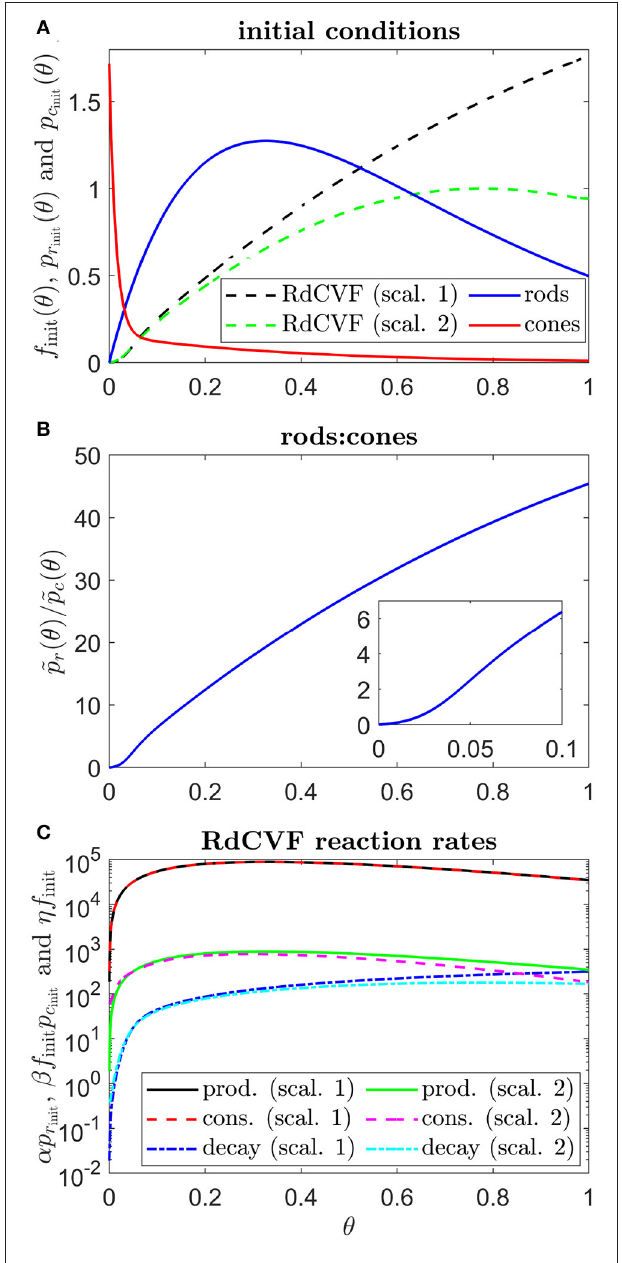
FIGURE 3 | Initial conditions, ratio of rods to cones and RdCVF reaction rates. (A) initial conditions used in all simulations, consisting of healthy rod and cone profiles and the corresponding RdCVF profiles under Scalings 1 and 2 (the legend applies to (A) only). (B) variation in the healthy rod:cone ratio, ˜ p r ( θ ) / ˜ p c ( θ ), with eccentricity. (C) RdCVF production, consumption and decay rates under Scalings 1 and 2 (Equation (1), the legend applies to (C) only). To obtain f init ( θ ) in (A,C) , Equations (1) and (4) were solved at steady-state using the finite difference method, with 4001 mesh points, where p r ( θ ) = p r p c ( θ ) = p c ( θ ). Under Scaling 1, α = 7.01 × 10 4 and β = 1.79 × 10 6 , while init under Scaling 2, α = 7.01 × 10 2 and β = 1.79 × 10 4 . Remaining parameter values as in Table 2